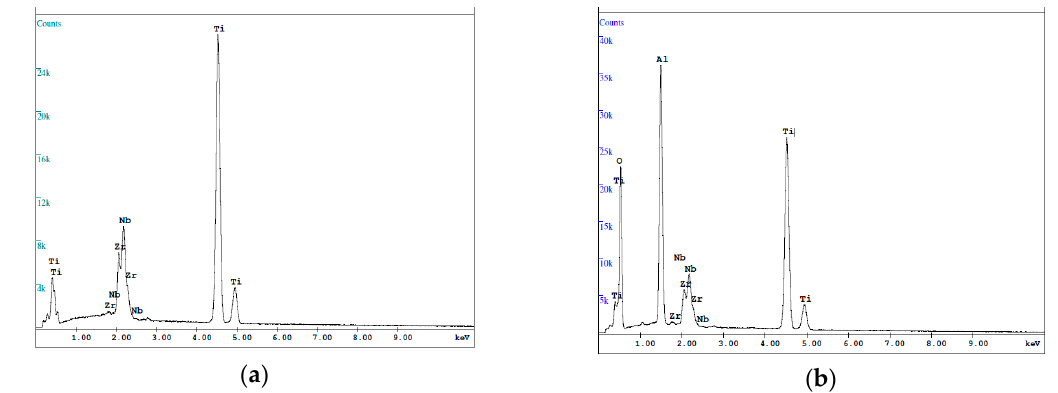
Figure 4. Results of Energy Dispersive Spectrometer (EDS) analysis after different surface treatments: ( a ) Solid bar, Untreated SLM, Etched SLM, Ground SLM; and, ( b ) Sandblasted SLM (the presented pictures are representative for three analyses of each surface treatment specimens).